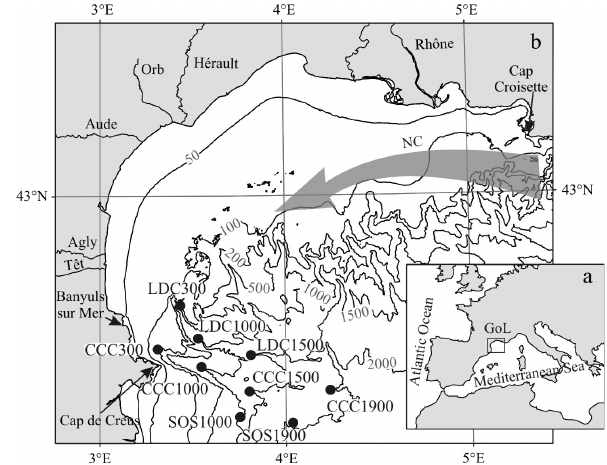
Fig. 1. (a) Location of the Gulf of Lion (GoL) in the Western Mediterranean Sea and (b) sediment trap mooring stations (black dots) along the tree transects studied: Lacaze-Duthiers Canyon (LDC), Cap de Creus Canyon (CCC), and their Southern Open Slope (SOS). Superficial main oceanic circulation is represented by the Northern Current (NC, grey